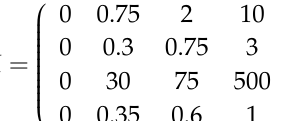
Type of Consequence Environmental Direct Economic Damage Loss / 100 Million ¥ Recovery / Million ¥